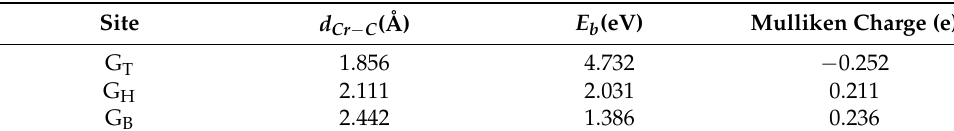
Figure 4. The total density of state (TDOS) ( a ) and partial density of state (PDOS) ( b ) of GeG system at T doping site. Table 2. The structural parameters of Cr-doped graphene.